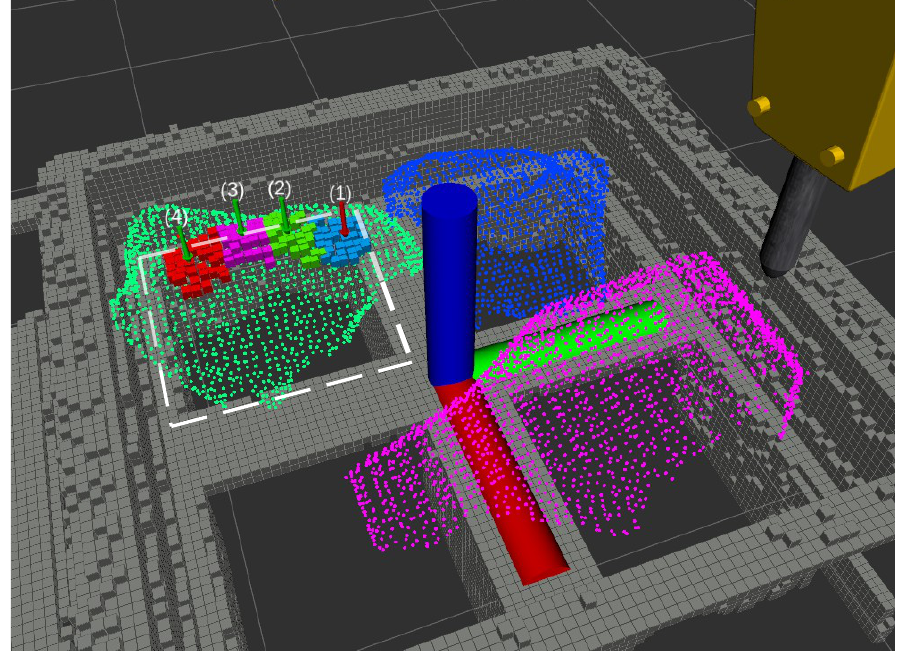
Figure 17. Result of applying Criterion 1 and Criterion 3. The blue, green, and red cylinders, correspond to the grill axes ( Z , Y and X , respectively). The red and green axes representation, in this case, also determine the quadrant’s separation. The white dashed line delimits the preferred quadrant. The green rock corresponds to the rock that is positioned within the preferred quadrant. The gray voxels correspond to the grizzly model. Numbered arrows represents the generated breaking